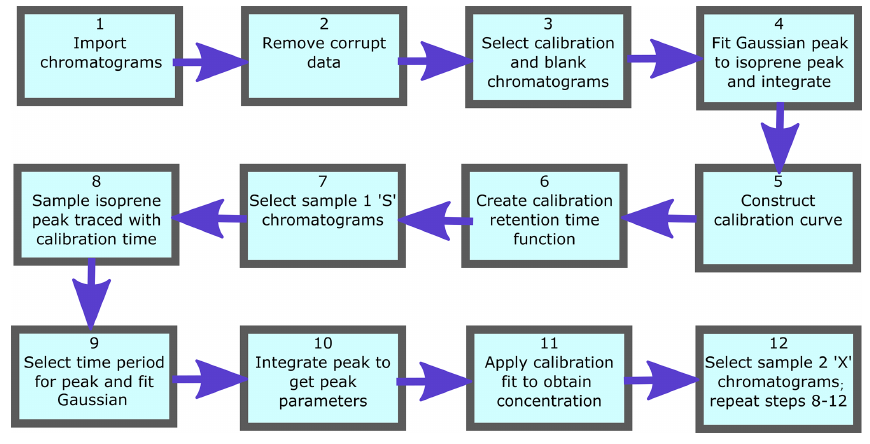
Figure 5. Analysis script flow